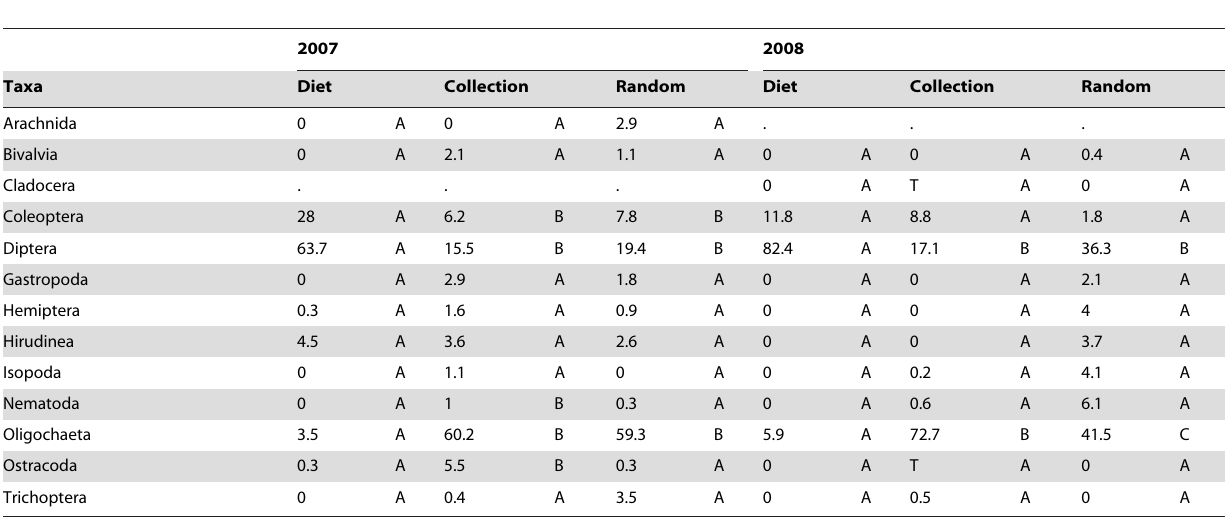
*Values with different letters within rows indicate significant differences of least-squares means (Tukey-Kramer test: P # 0.05) within that year. T indicates a trace amount of material